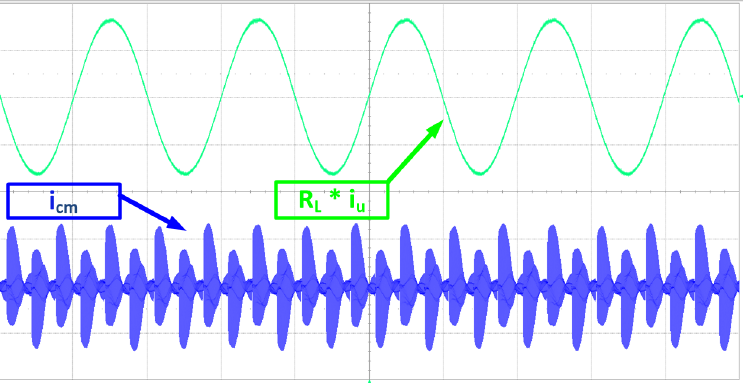
Figure 27. Experimental waveforms. R L · i u ( t ) (upper trace, 200V/div), i cm (lower trace, 200mA/div). The time division is